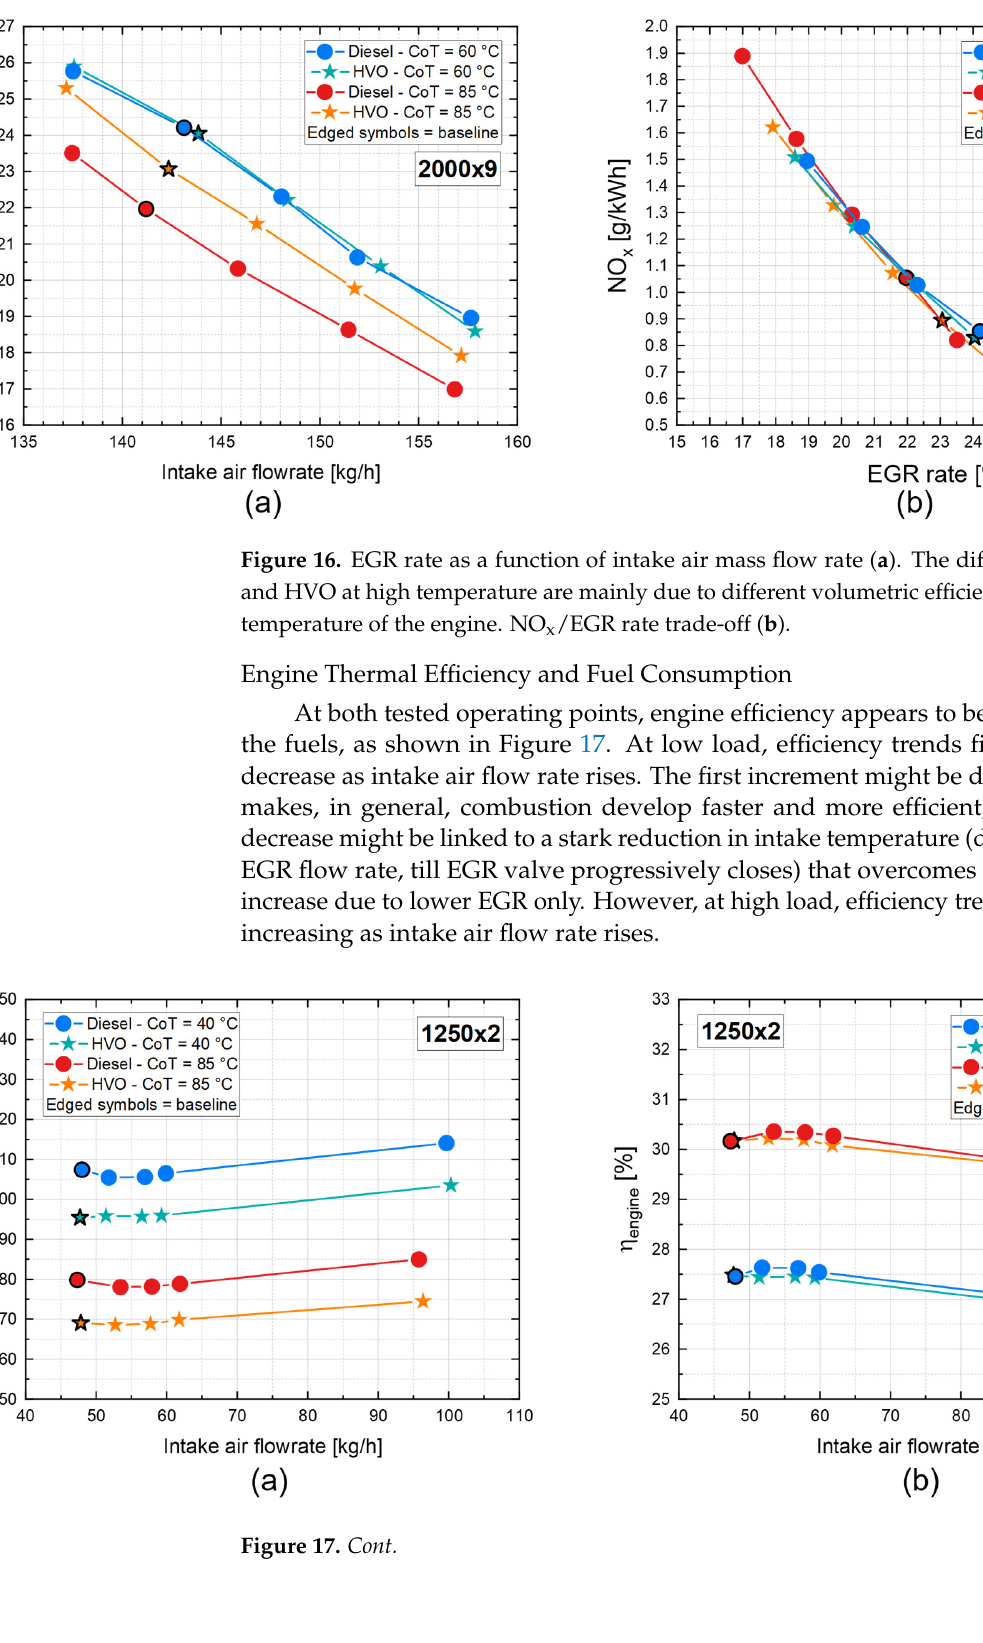
Figure 17. bsfc and engine efficiency along intake air quantity sweep tests at 1250 × 2 ( a , b ) and 2000 × 9 ( c , d ). Comparison between diesel and HVO at high and low coolant temperatures. Warm colors represent high coolant temperatures, while cool colors represent low coolant temperatures. Circles represent diesel, while stars represent HVO. 4. Conclusions The performance of a diesel engine running on either conventional diesel or HVO at different engine coolant temperatures was examined in this paper. In the first part of the experimental campaign, warm-up/cool-down ramps were performed on two engine op- erating points. Upon overnight soaking at room temperature, the engine was “naturally” warmed up until the coolant temperature reached 85 °C. Then, by “artificially” adjusting the heat transfer on the coolant side, the coolant water temperature was decreased. A hys- teresis pattern on the engine thermal state was highlighted in terms of overall engine be- havior and exhaust emissions, whether the engine was just started and “naturally” warmed up or “artificially” cooled down and stabilized at low coolant temperatures. Next, sweep tests were carried out (on the same engine operating points as the ramp tests) in which the engine was maintained at either high or low coolant temperatures while several engine calibration parameters (SOI Main , p Rail and q air ) were varied one-factor at a time, in order to highlight their individual effect on exhaust emissions and engine performance.